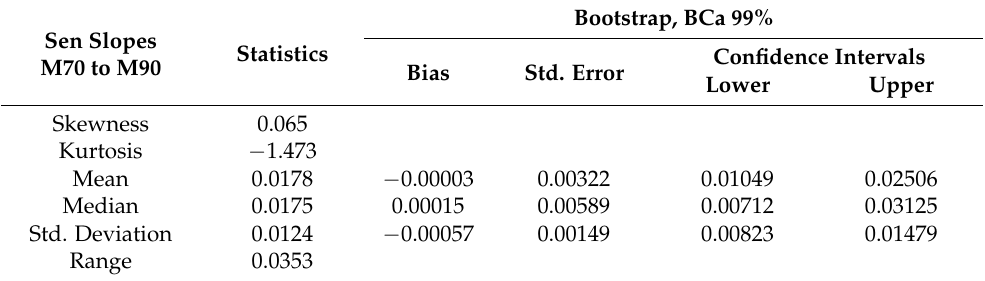
Table 13. Inferential statistics of Sen Slopes for inter decadal runoff difference between M70 and